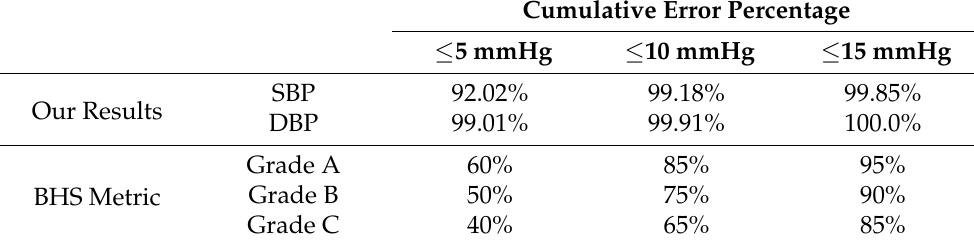
Table 9. Evaluation of BP prediction in Experiment 1 in terms of British Hypertension Society (BHS) Standard.